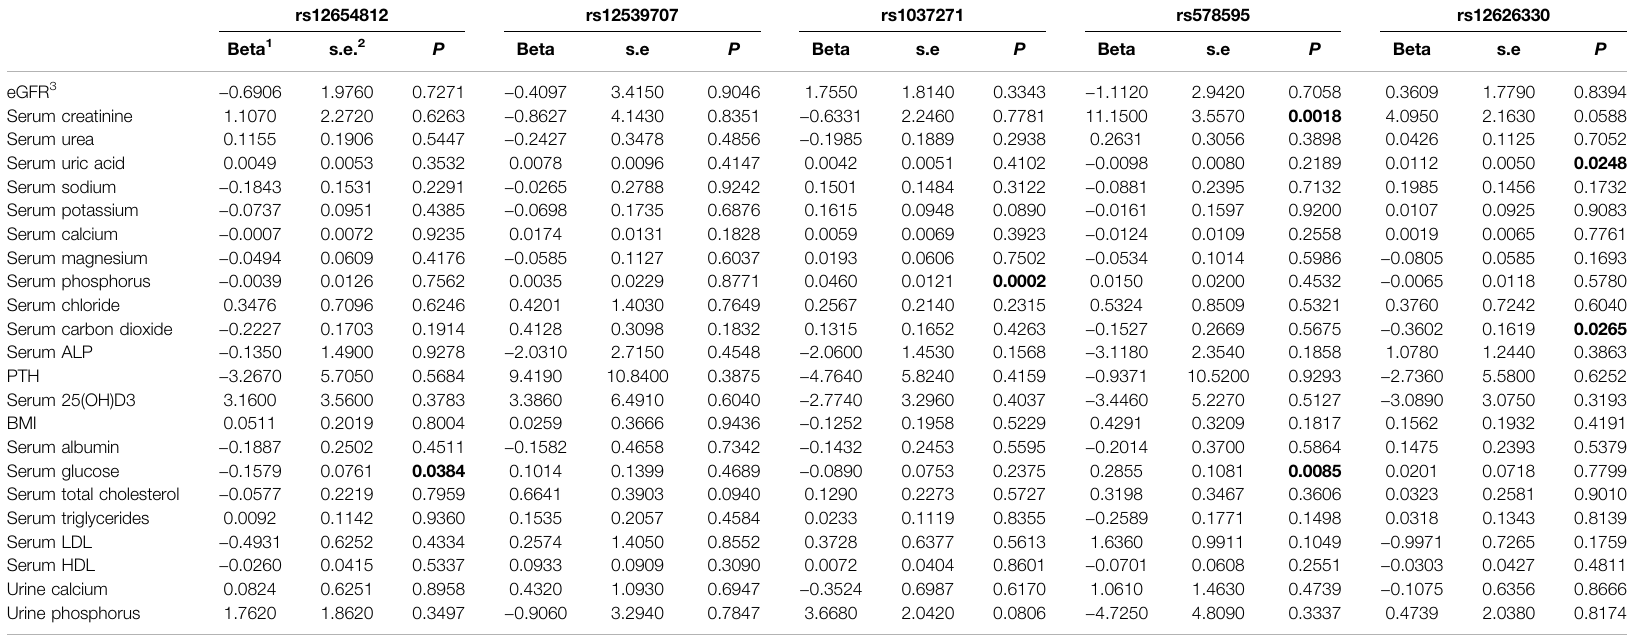
TABLE 3 | Multiple linear regression analyses for clinical